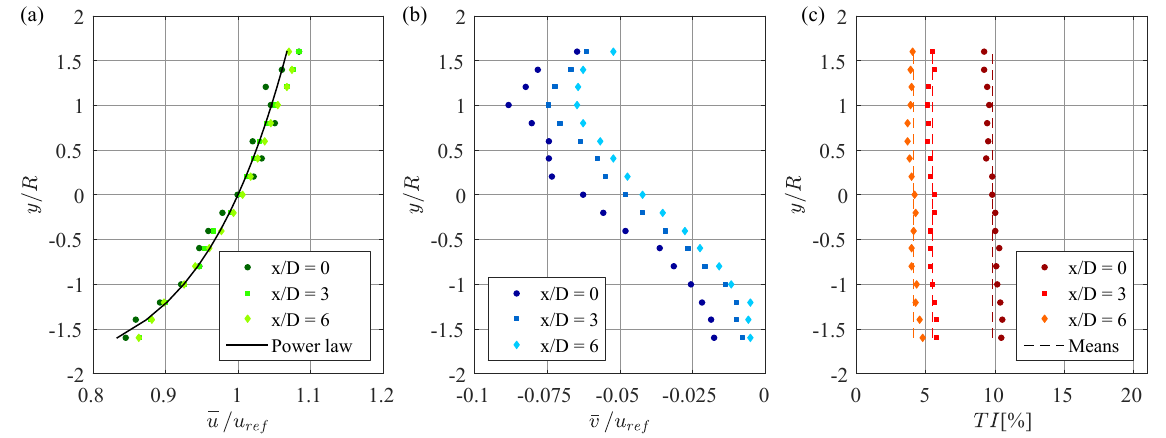
Figure 4. Vertical flow profiles in the empty wind tunnel at different positions, in which x/D = 0 refers to the position where the NTNU turbine is thereafter located: (a) normalized streamwise velocity u ∗ , (b) normalized vertical velocity v ∗ , and (c) turbulence intensity, TI (%). The radius R and diameter D refer to the NTNU